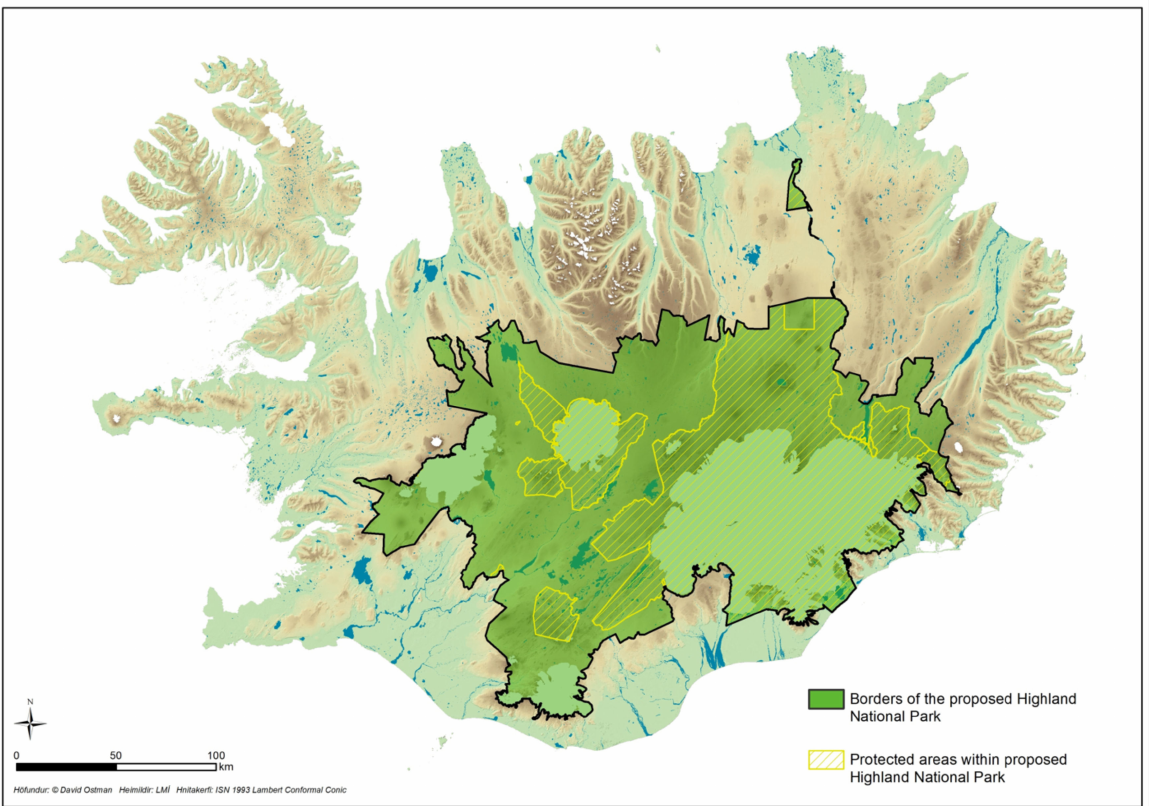
Figure 1. Border of the proposed Central Highlands National Park